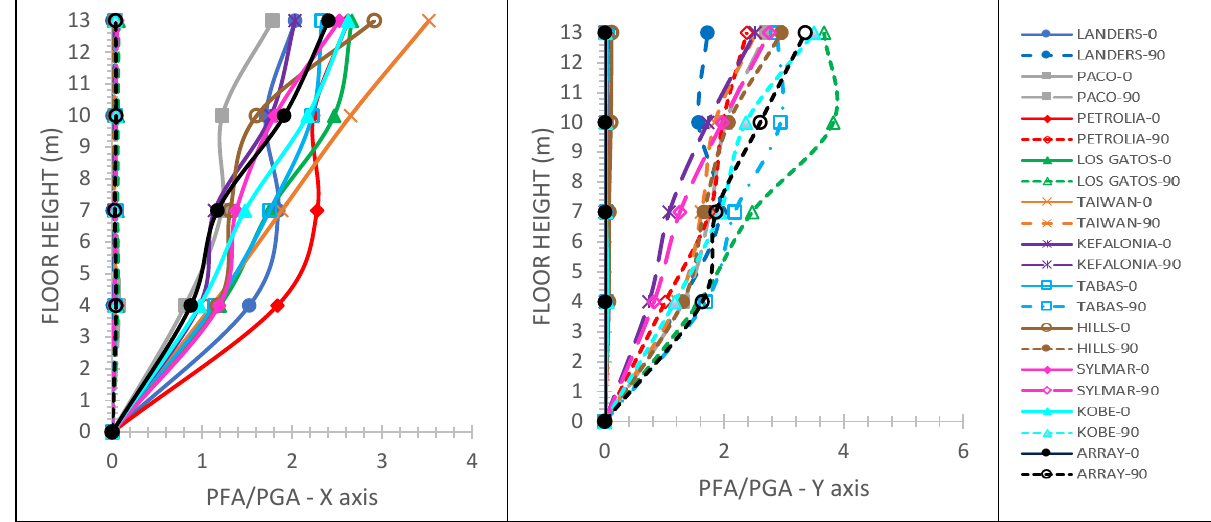
Figure 14. PFA/PGA along X ( left ) and Y ( right ) horizontal directions of the four-story mixed building, considering the fixed-pinned connection of the steel structure to the r/c one.